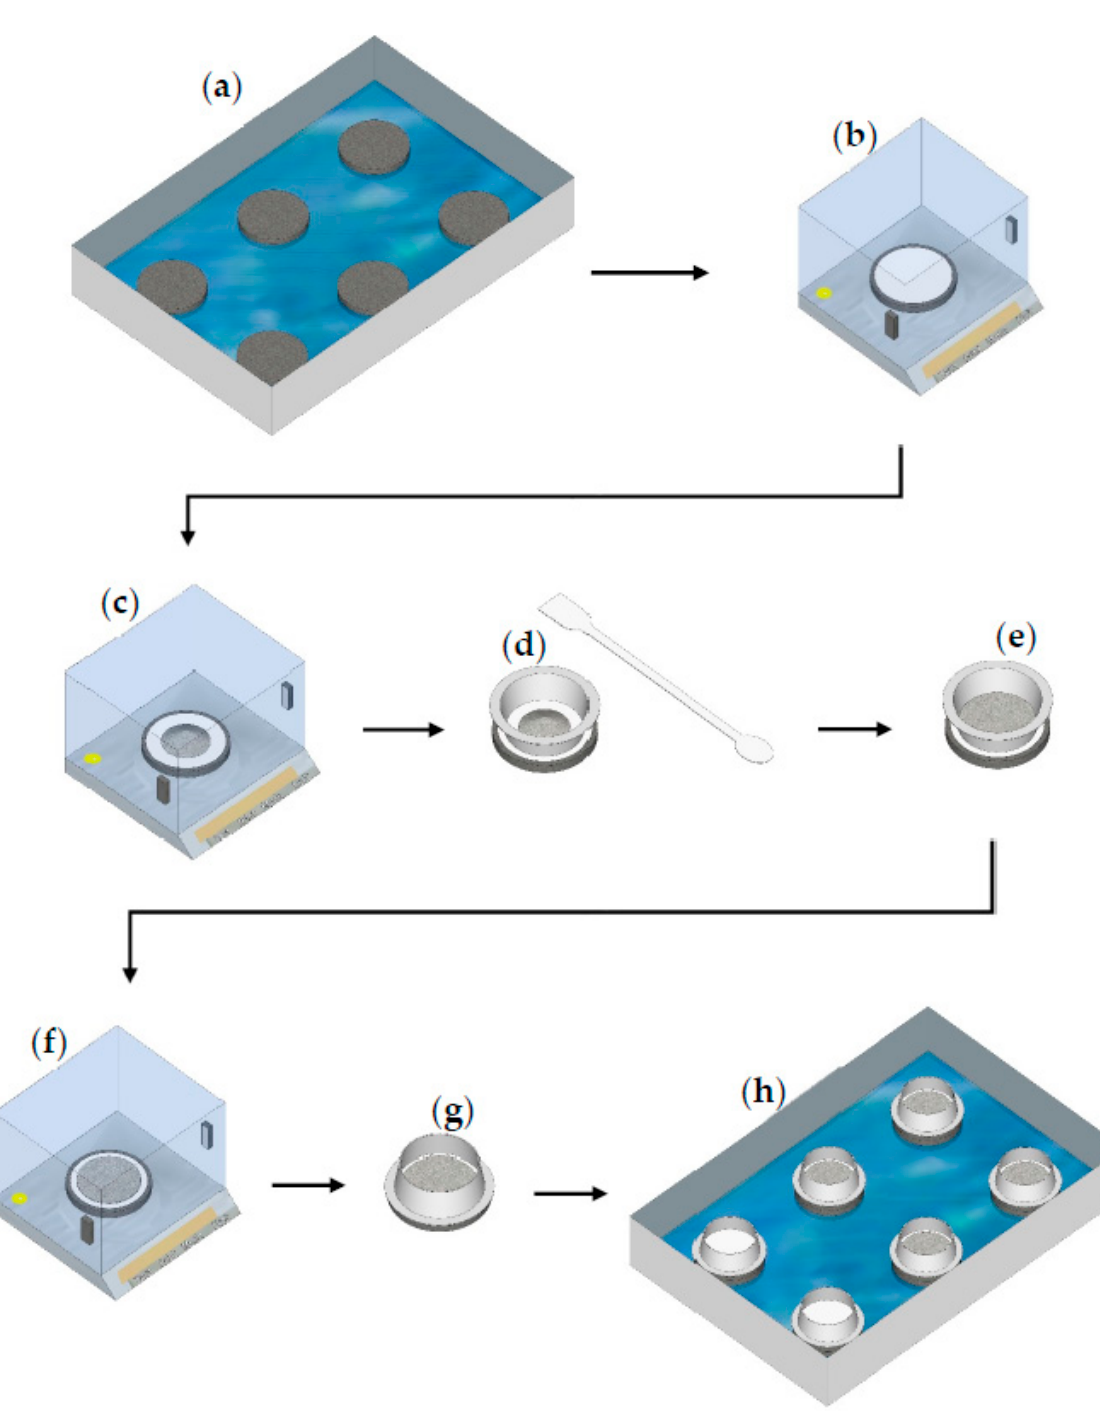
Figure 3. Steps of the initial water uptake test: ( a ) place two porous stones on top of each other in a large plastic container with water (water level = height of one porous stone); ( b ) tare the mass of the third (dry) porous stone + filter paper; ( c ) measure out ~5 g of sample; ( d , e ) with the help of a spatula and a downpipe pop, create a thin layer of sample with a 75 mm diameter; ( f ) re-weigh the sample and record the value; ( g ) place the downpipe pop around the flattened sample with the rimmed side down (D = 85 mm); and ( h ) start the IWU test by placing the third porous stone with the sample on top of the porous stone stack (containing two porous stones) in the large container with water (run the test for 1 min).